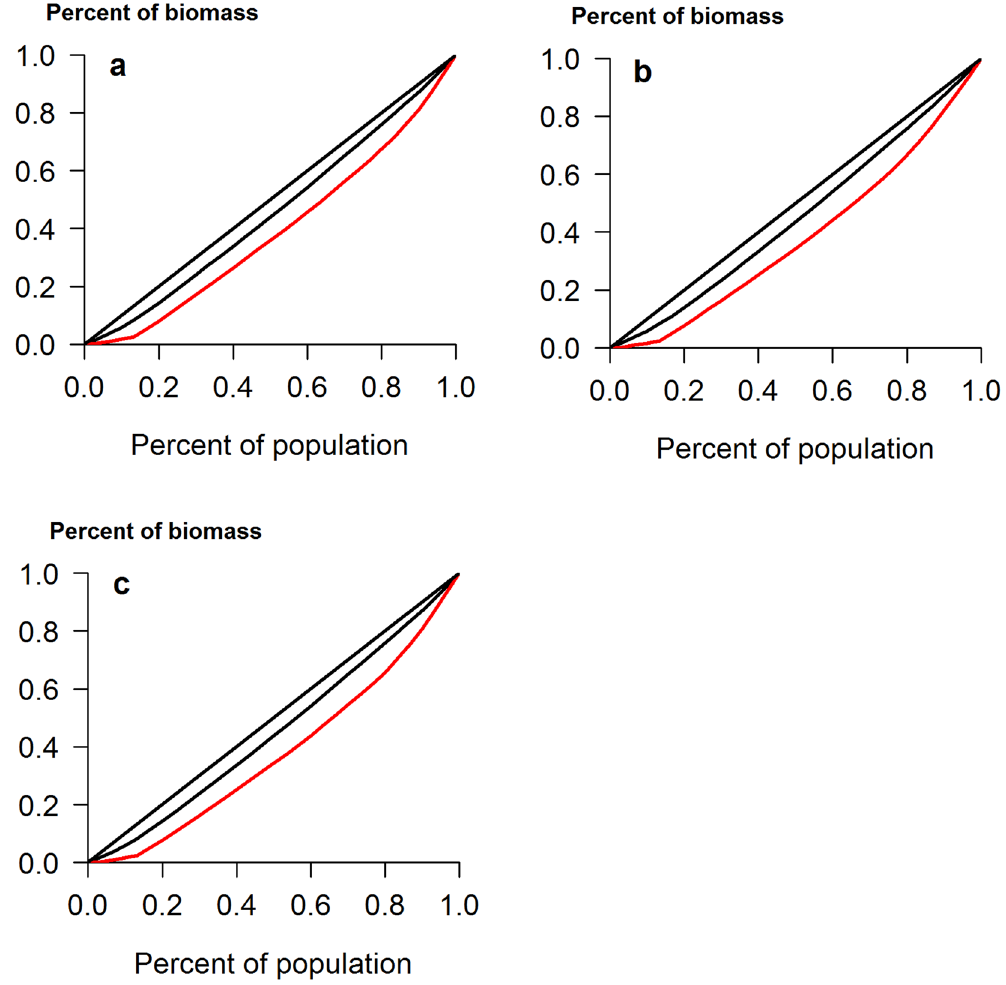
Figure 2. Lorenz curves for ( a ) total biomass, ( b ) root biomass and ( c ) shoot biomass of calabrese plants grown in the controlled experiment. The diagonal straight line represents the line of equality. Control plants depicted in black, PGPR addition in